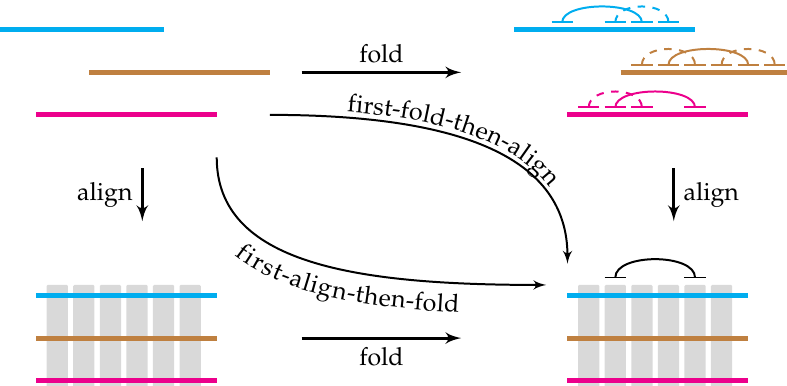
Figure 1. A “commutative diagram” of the alignment and folding tradeoff. Top left: unaligned RNA sequences. Bottom left: their structure-agnostic alignment; conserved regions are shown in gray. Top right: sparse folding identifies candidate helices shown as arcs. Bottom right: conserved helices are matched by structure-aware alignment or identified in a multiple sequence